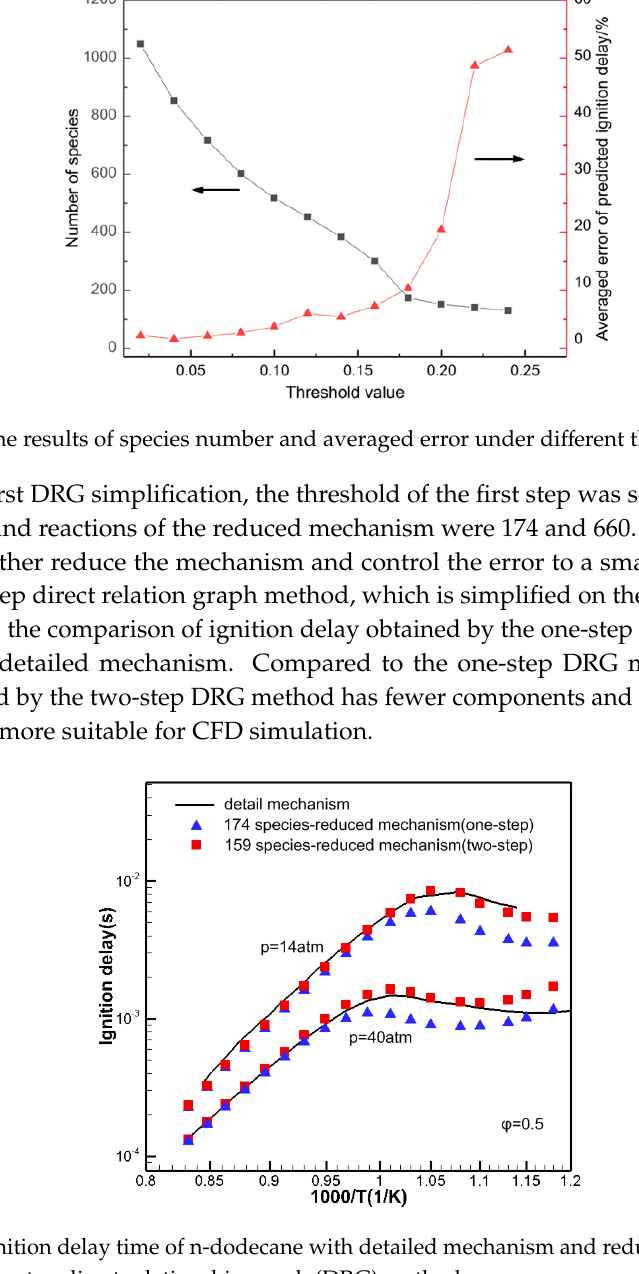
Figure 3. Rate of production C 12 H 26 in a perfectly stirred reactor (PSR) at P=0.1MPa, ϕ =0.5. The n-dodecane skeletal mechanism consists of three parts: the oxidation mechanism of the C 12 macromolecular component from the simplified mechanism, the C 2 -C 3 transition mechanism from the Westbrook et al. [12] model and the detailed H 2 /CO/C 1 sub-mechanism from Klippenstein et al. [22]. The main reaction pathway is shown in Figure 4.